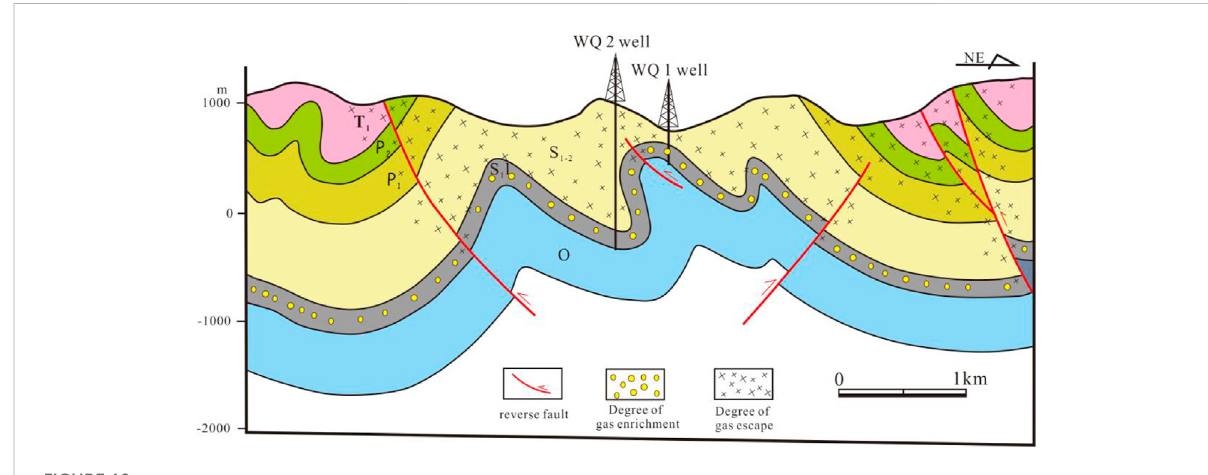
FIGURE 10 Structural preservation mode of shale gas enrichment and accumulation in the Wufeng − Longmaxi Formation-lost destruction